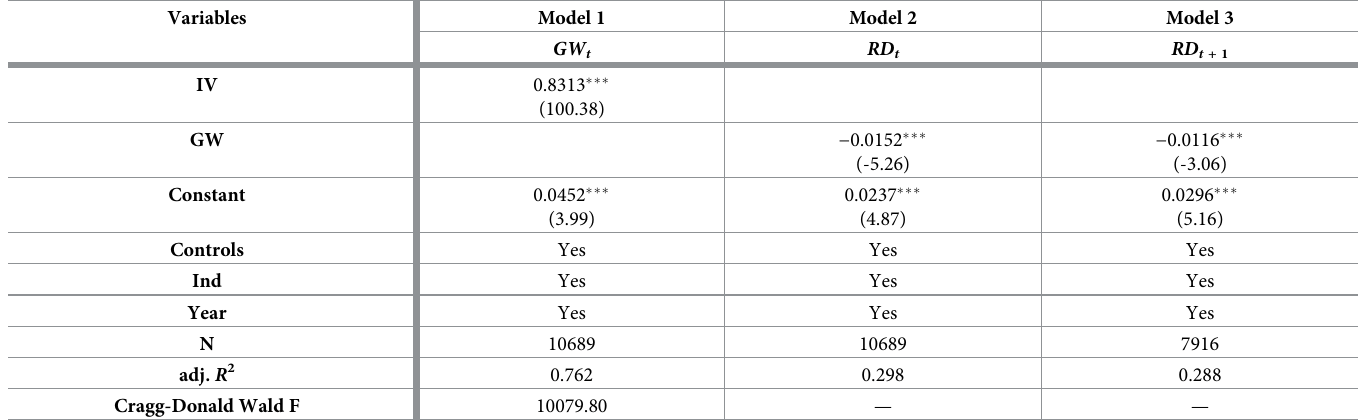
Table 7. Regression analysis results of endogeneity with